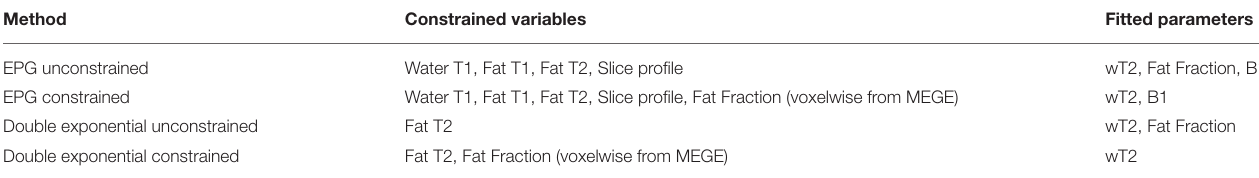
TABLE 1 | Overview of the presented fitting